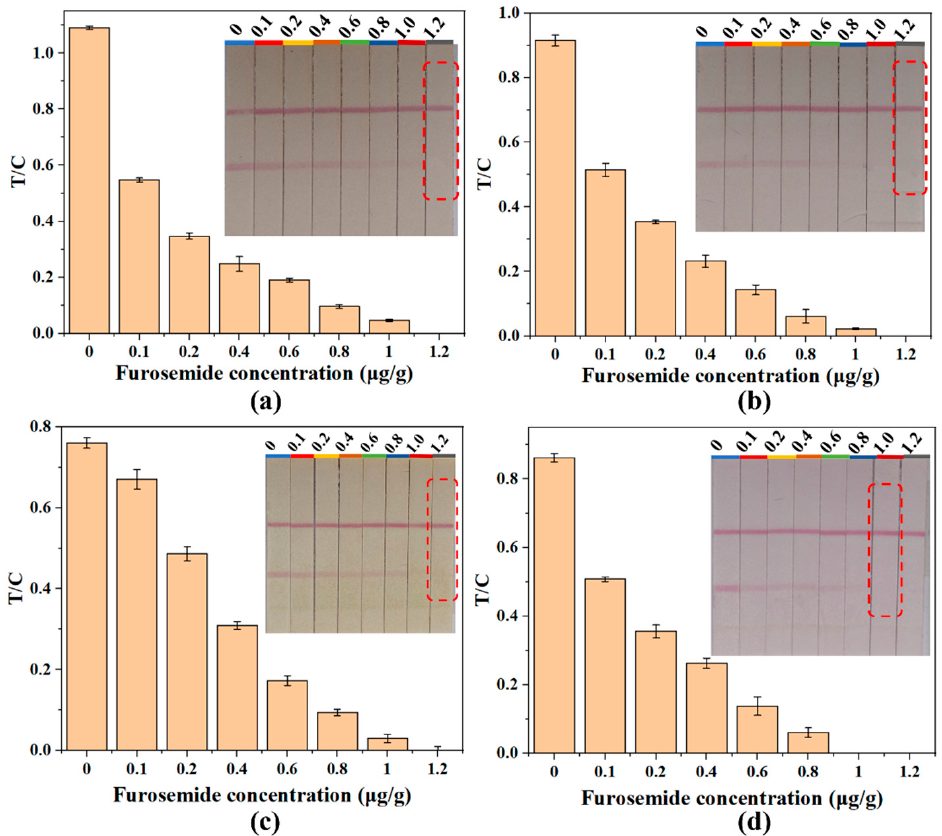
Figure 4. Sensitivity evaluation of the Au nanoparticles lateral flow immunochromatography (AuNPs-LFIA) for furosemide in slimming health foods of different substrates. Red rectangular boxes indicate the color intensity at the cut-off concentrations. Results for determination of furosemide in the slimming capsule samples ( a ), slimming coffee samples ( b ), slimming tea samples ( c ) and slimming tablet samples ( d